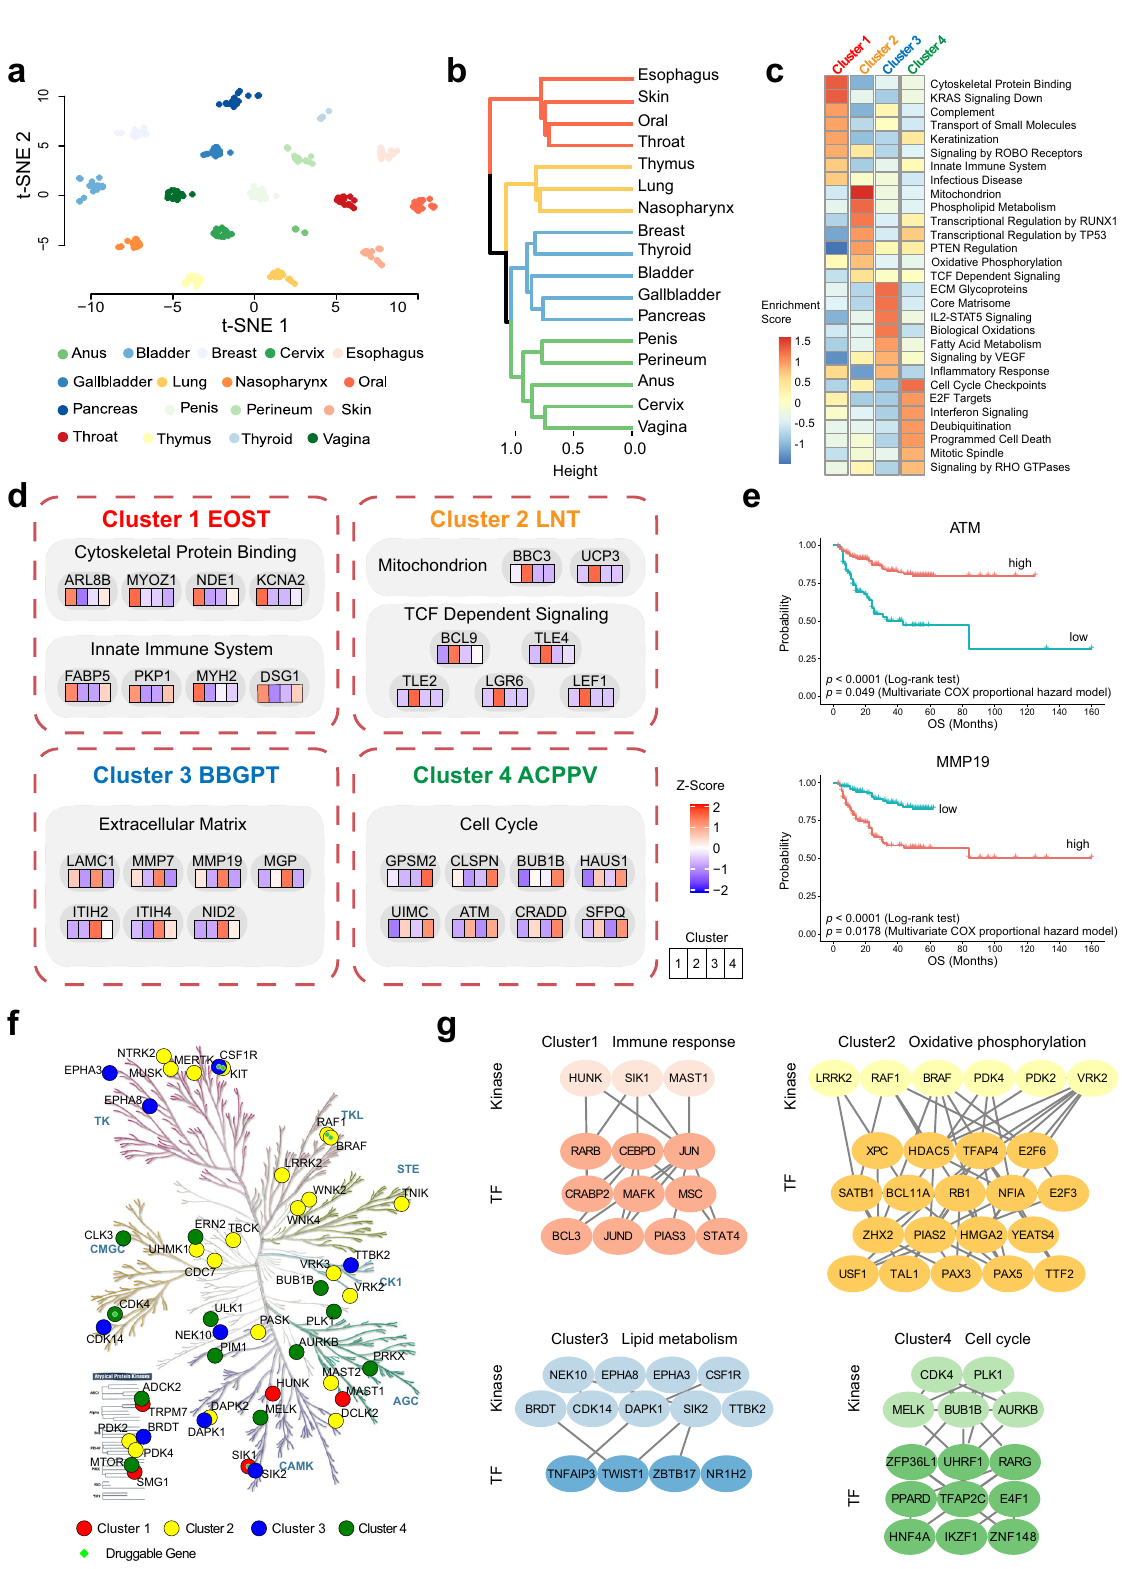
perineum, anus, cervix, and vagina, with the best prognosis (Supplementary Fig. 8b, c). Notably, ACPPV with a high HPV infection frequency was enriched for cell cycle checkpoints,